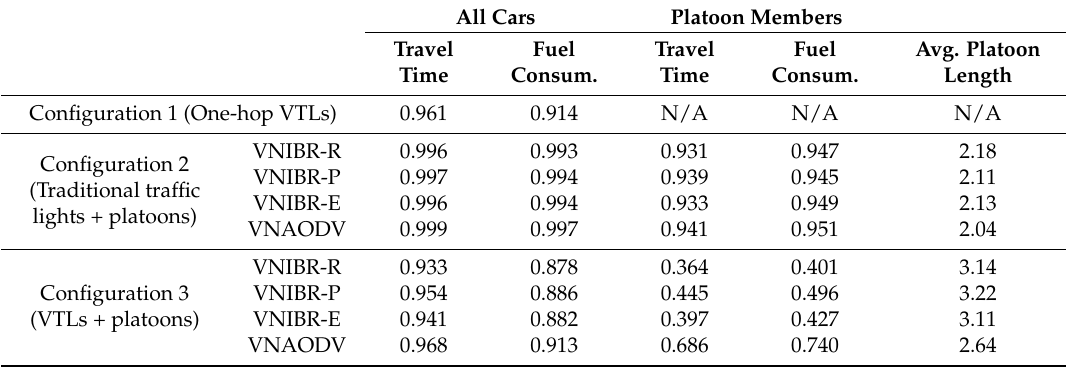
Table 1. Results for low traffic density (time and fuel normalized regarding best average values from configuration 0).